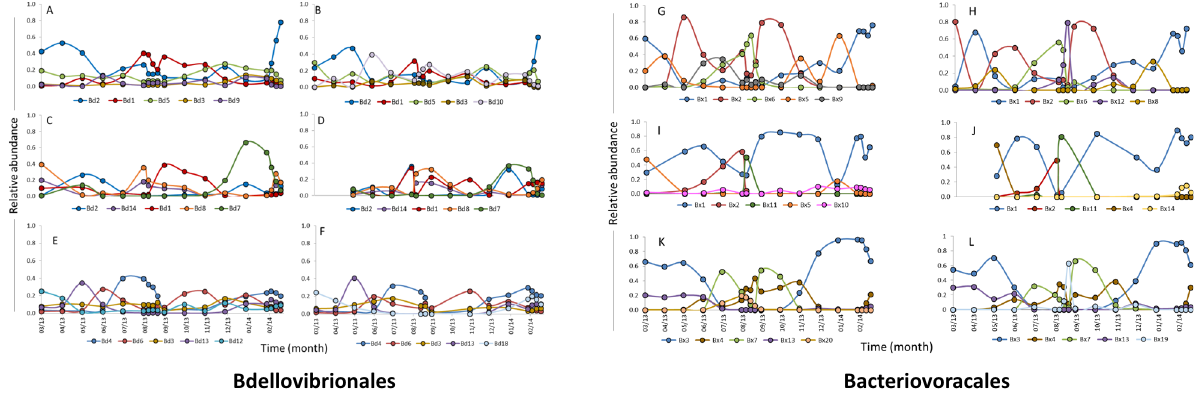
Fig. 3 Yearly dynamics of BALOs. Annual dynamics of the fi ve most abundant Bdellovibrionales ( A – F ) and Bacteriovoracales ( G – L ) OTUs at the Shafdan ( A , B , G , H ), Al-Bireh ( C , D , I , J ), and Langenreichenbach ( E , F , K , L ) WWTPs over a year, with 18 sampling times. A, C, E, G, I, K: fl ocs. B, D, F, H, J, L: liquor. Relative abundances are based on read numbers.